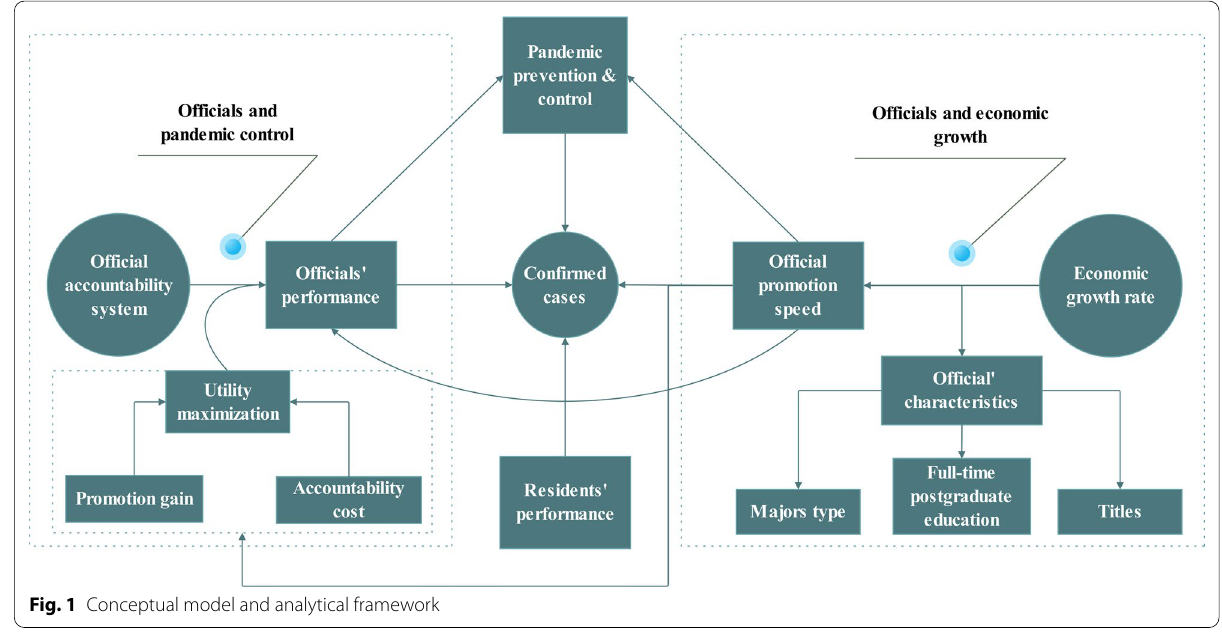
Fig. 1 Conceptual model and analytical